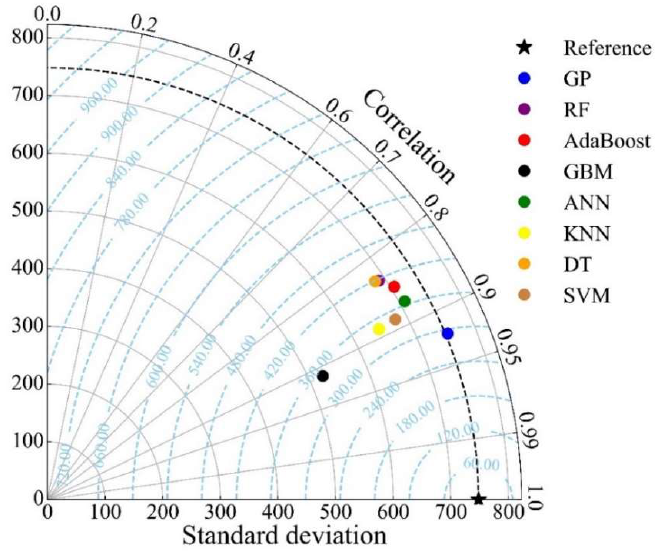
Figure 12. Taylor diagram of the test set (RF: random forest, ANN: artificial neural network, DT: decision tree, SVM: support vector machine, KNN: k-nearest neighbors, GBM: gradient boosting machine, AdaBoost: adaptive boosting machine).